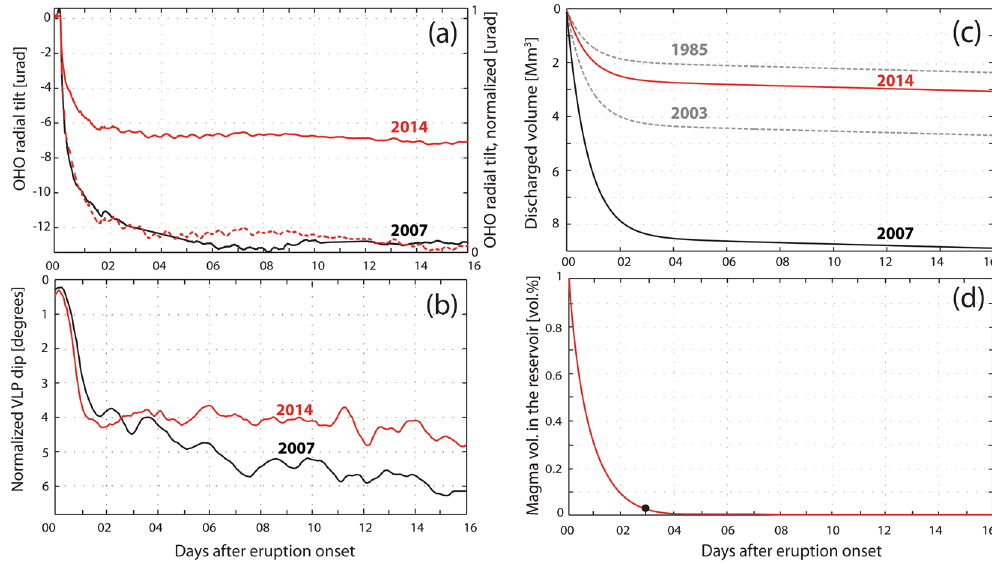
Figure 4. ( a ) Ground deformation during the 2007 (black) and 2014 (red) effusive eruptions, recorded by a borehole tiltmeter at the station OHO. The normalized ground deformation (dashed red for the 2014) is also shown. Tiltmeter locations are reported in Fig. 1. ( b ) The normalized VLP dip for the 2007 and 2014 eruptions. ( c ) Discharged volumes during the 2014 (red) and 2007 (black) eruptions. 1985 and 2003 trends are also shown (dashed gray) for comparison. ( d ) Percentage of the magma volume drained from the reservoir, modeled using equation (5). Despite the volume of magma considered, the model predicts that the drainage of the volume stored in the reservoir always follows the same exponential discharge trend. The largest decompression rate coincides with the inflection point (black dot) of the discharge trends, which indicates that 98% of the magma volume is drained out of the reservoir in the first 3 days of the effusive eruption (equation (10)).